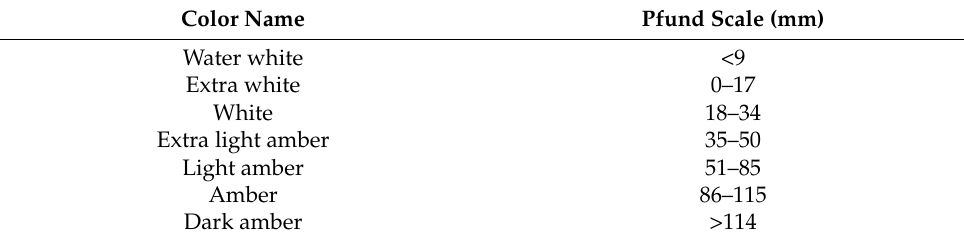
Table 2. Pfund color scale